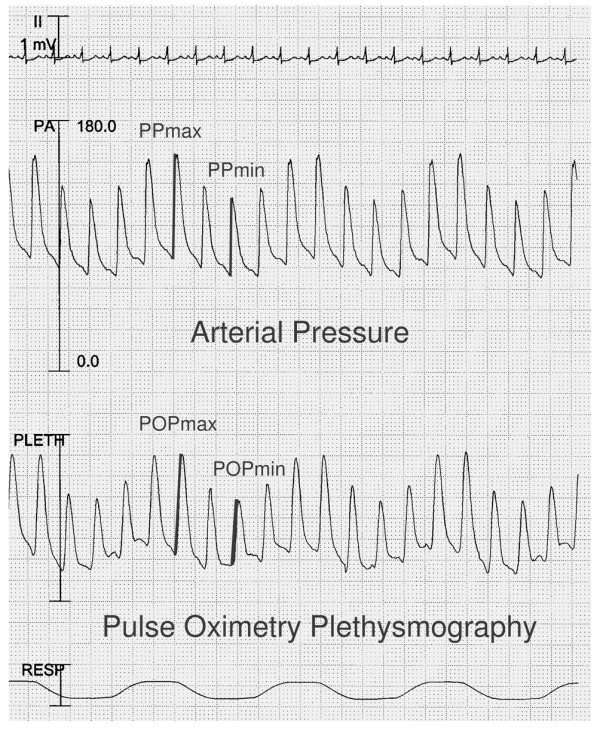
Comparison between invasive arterial pressure and pulse oxymetry plethysmography recordings. Simultaneous recording of electrocardiographic lead (II), systemic arterial pressure (PA), pulse oximetry plethysmography (PLETH) and respiratory signal (RESP) in one illustrative patient. POP, pulse oximetry plethysmographic; PP, pulse pressure.